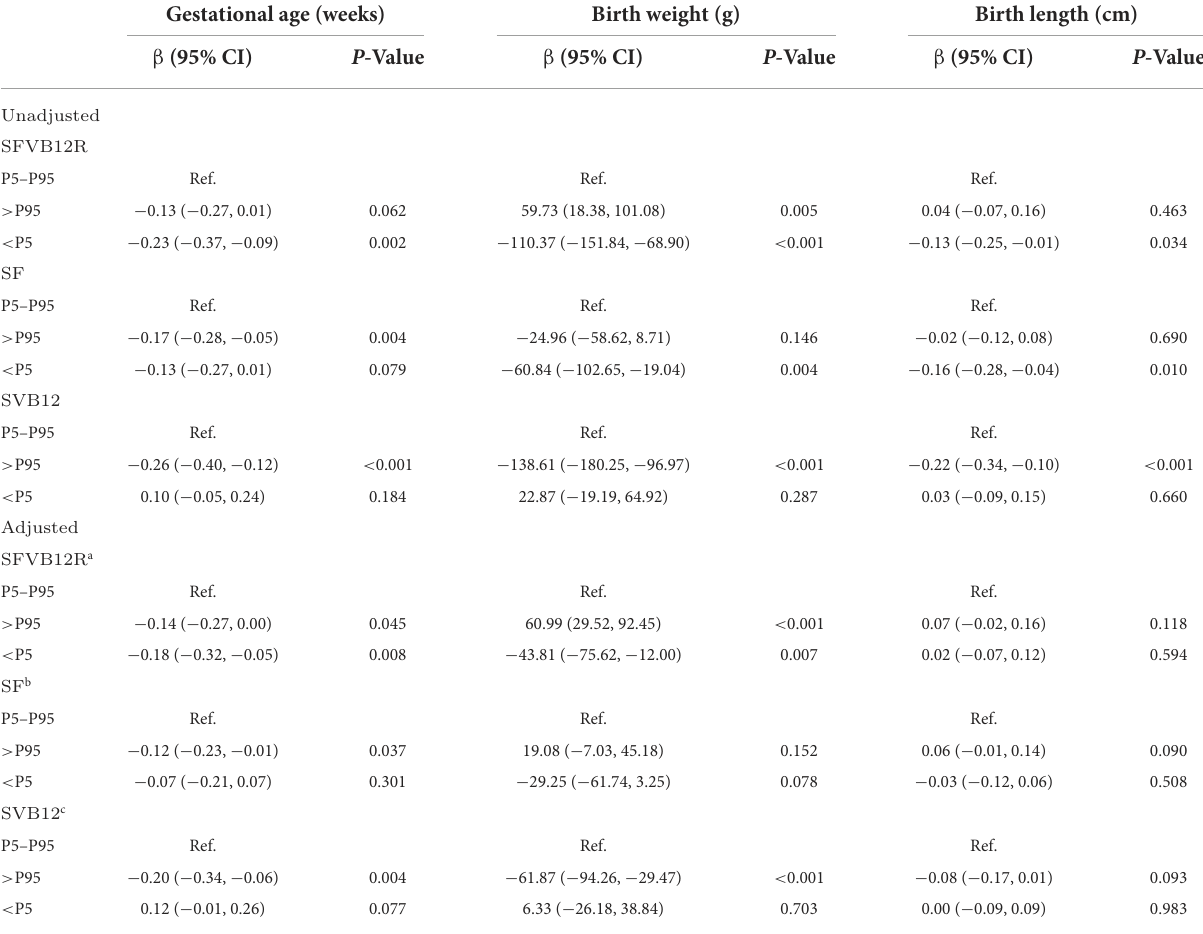
TABLE 5 β (95% CI) for fetal development associated with categories of maternal SF, SVB12 levels, and their ratio. Gestational age